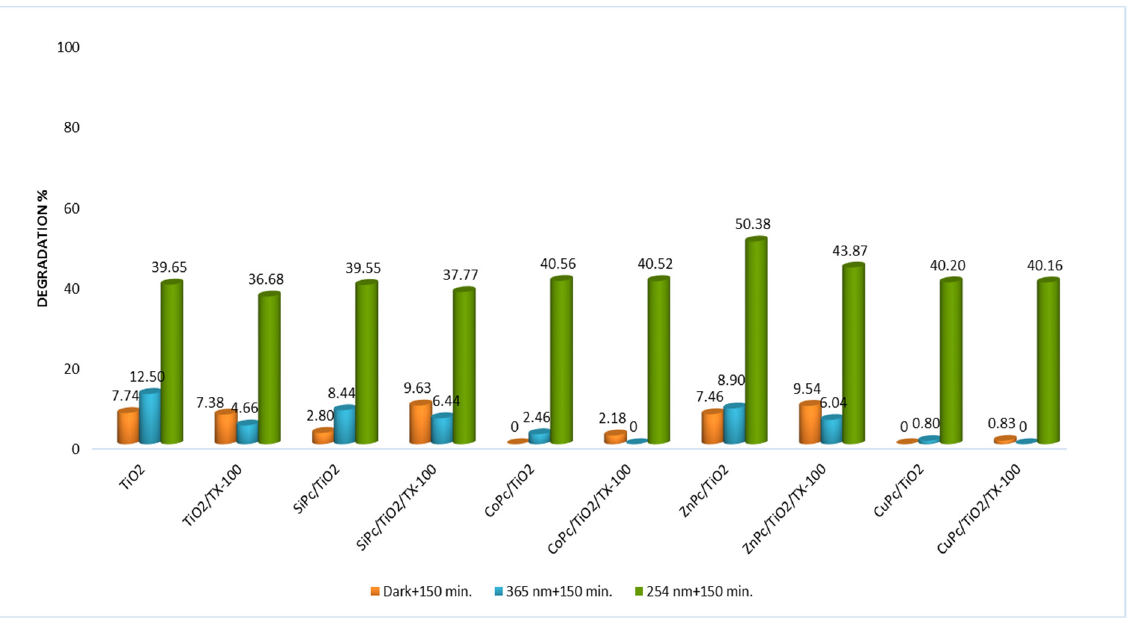
Figure 10. Comparison of photocatalytic degradation of AMX ([AMX] 0 = 20 mg/L, mass = 1 g/L, t = 150 min.).